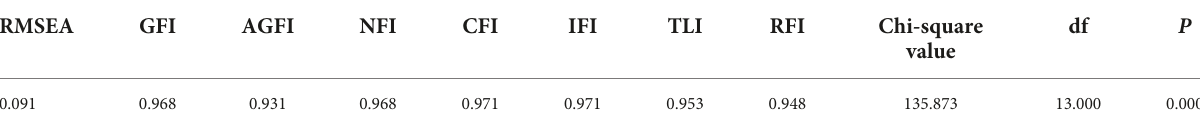
TABLE 7 Fitting index of the